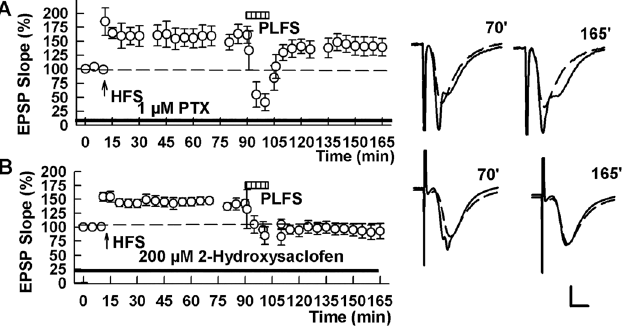
Fig 2. GABA-A but not GABA-B receptors contribute to TA-induced SC LTP-D. (A) In the presence of 1 μ M picrotoxin, a GABA-A receptor antagonist (PTX, black bar), PLFS (hatched bar) failed to depotentiate SC LTP. (B) 2-Hydroxysaclofen (200 μ M, black bar), a GABA-B receptor antagonist did not alter TA-induced LTP-D. Traces show representative EPSPs at the times indicted in the graphs. Calibration: 1 mV, 5